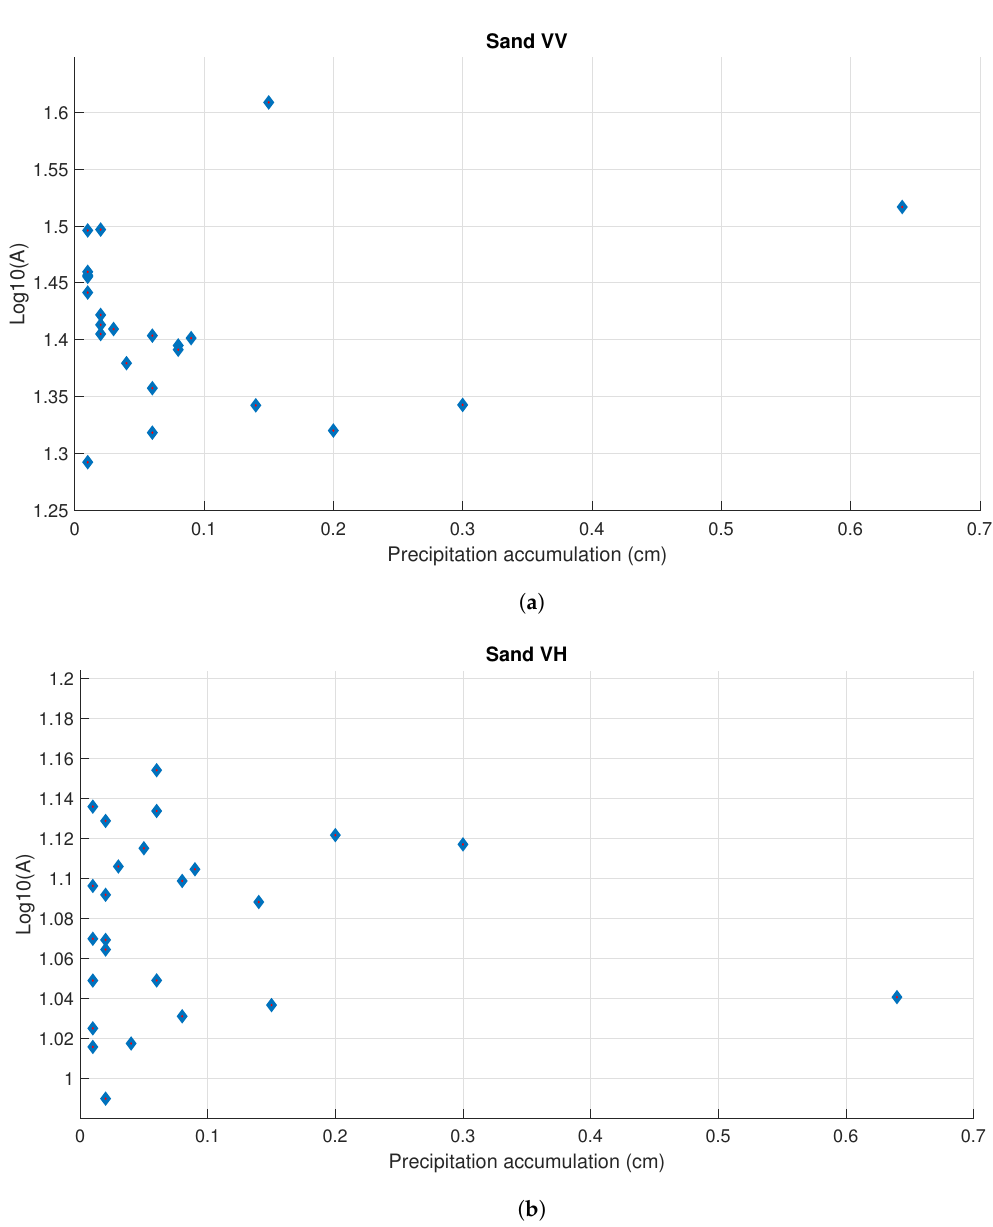
Figure 12. Scatter plot of amplitude values versus precipitation accumulation evaluated over two years on the sand mask for: ( a ), VH polarization; ( b ), VV polarization. No particular correlation or trend of the amplitude versus precipitation accumulation has been noticed in this